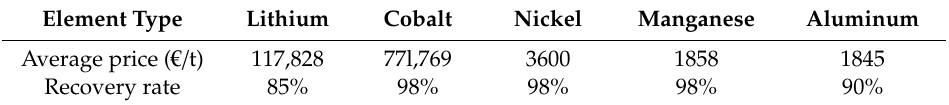
Table 5. Average market price and recovery rate of raw metal materials for power battery (2018).